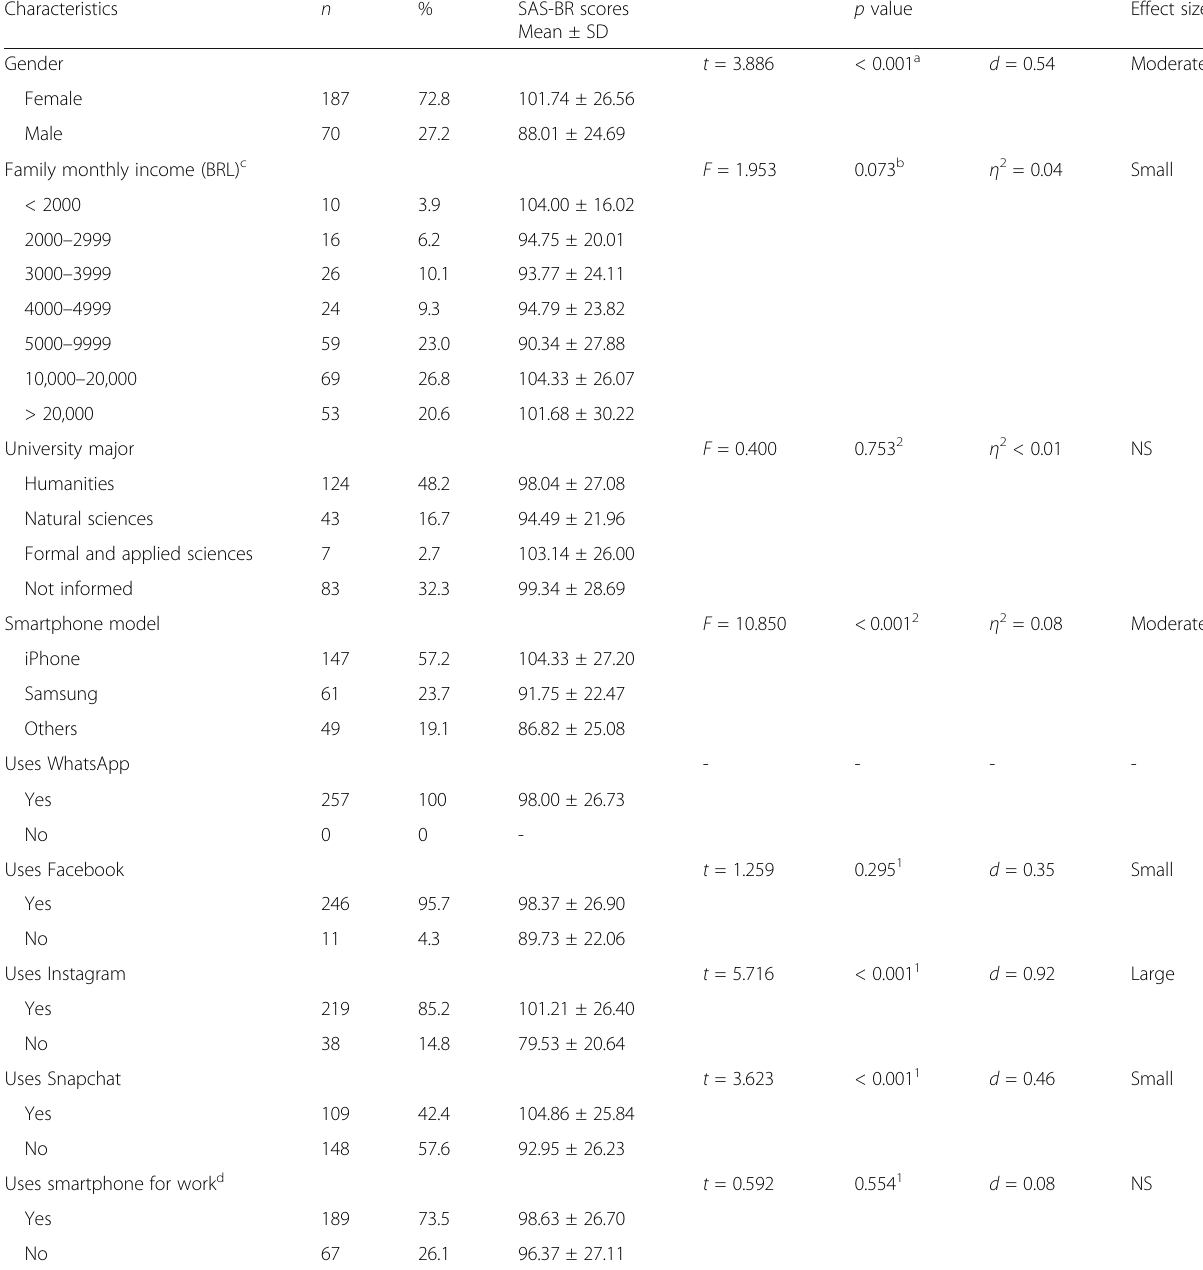
Table 1 Participant characteristics, smartphone usage patterns, and smartphone addiction scores of 257 Brazilian university students